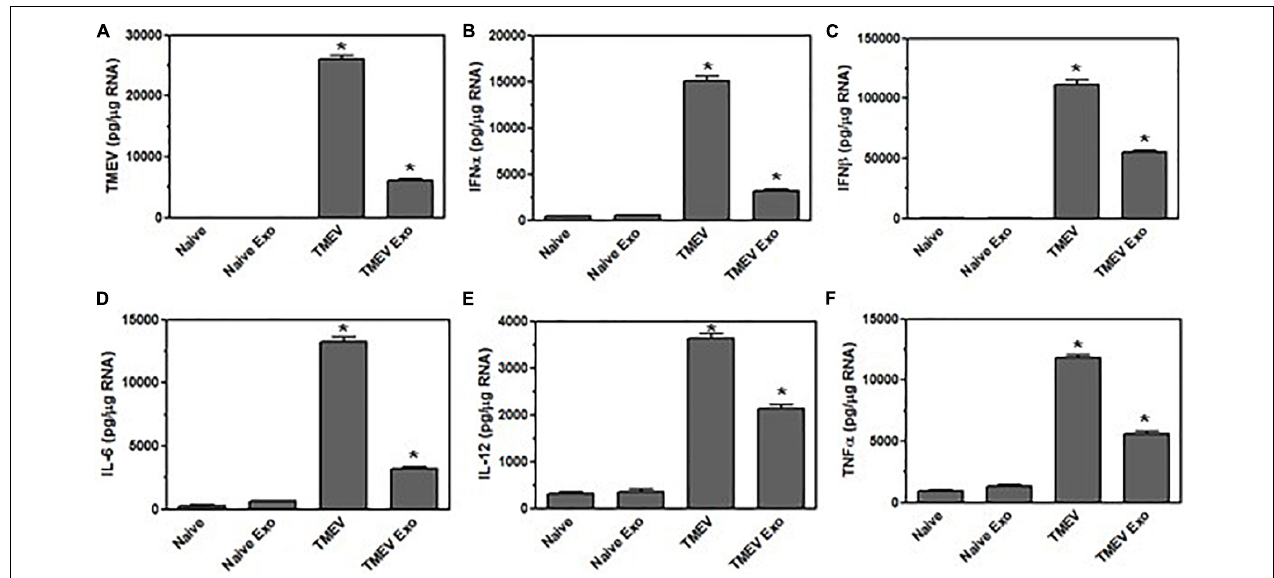
FIGURE 10 | Exosomes secreted by microglia during TMEV infection in mice activate an inflammatory response in naïve mice. Exosomes were isolated from the brains of TMEV-infected mice at 2 days post-infection or from naïve mice (three mice per group). The exosomes were sorted for CD11b + exosomes, and the CD11b + exosomes were injected into the brain of naïve mice. At 2 days post-injection, the brains were removed from the mice (three mice per group), and RNA was isolated, converted to cDNA and used in real time PCR with primers for TMEV (A) , IFN α (B) , IFN β (C) , IL-6 (D) , IL-12 (E) , and TNF α (F) . As comparison, the brains were removed from naïve mice or mice at 2 days post-TMEV infection, and RNA was isolated, converted to cDNA and used in real time PCR. Significant difference was determined by the one way ANOVA and Bonferroni’s multiple comparison test (* p < 0.001) based on the naïve mouse